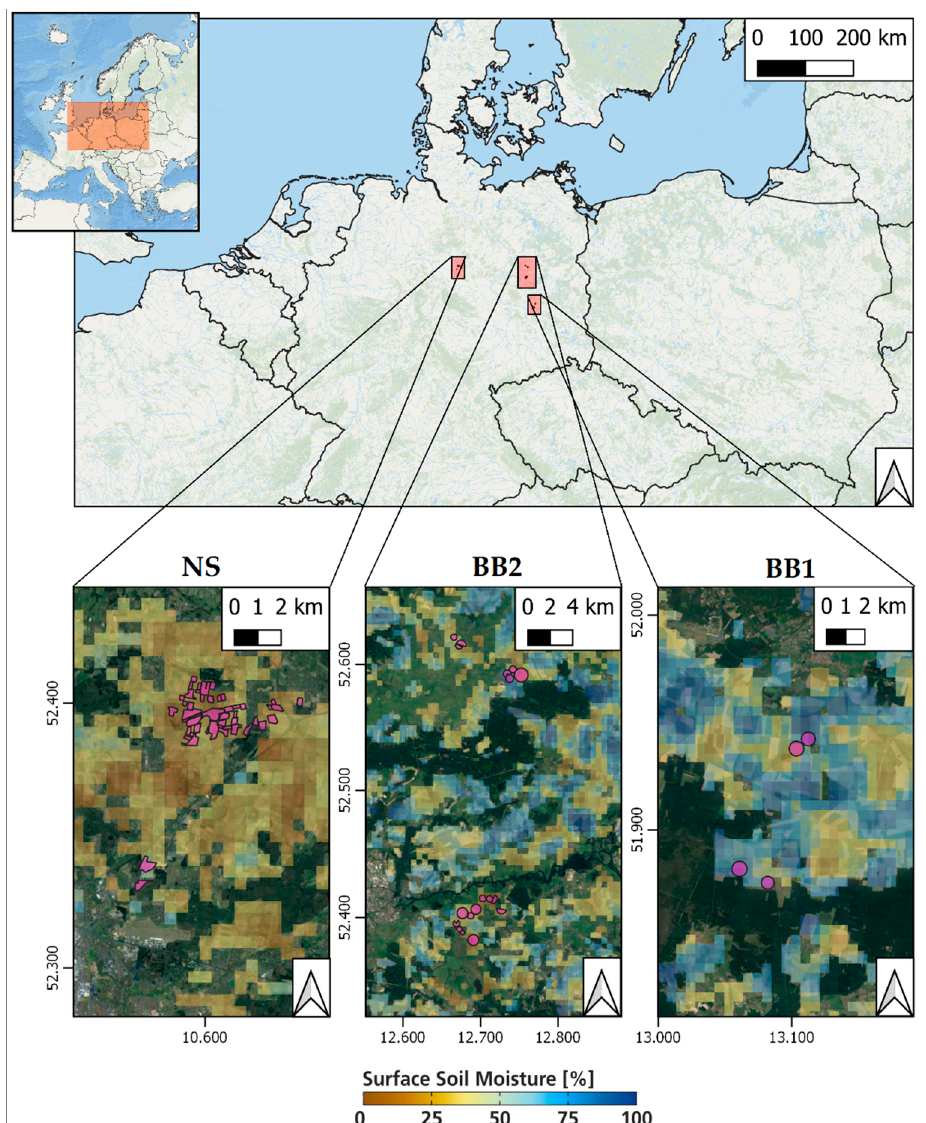
Figure 1. Location of the three study sites (base map from ESRI) and zoomed-in view of the individual sites and fields (base map from Google). Sentinel-1 Surface Soil Moisture maps for 7 June 2018, with non-agricultural pixels masked, are also shown.